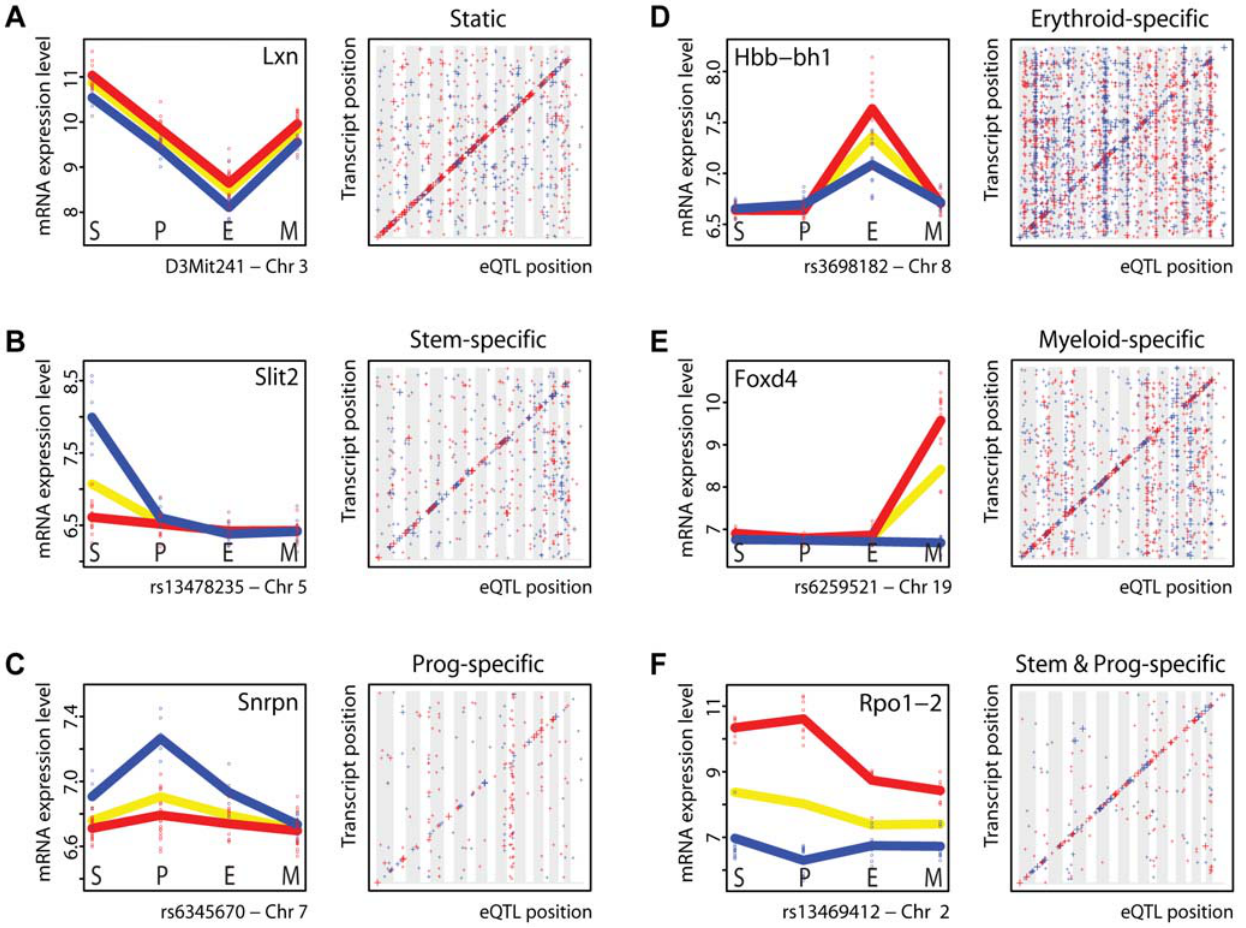
Figure 2. Identification of static and dynamic eQTLs. (A) Genome-wide identification of cell-type–independent static eQTLs. (Left panel) Lxn mRNA levels were analyzed in all 4 cell types. Each circle represents an individual sample (strain). The yellow line shows mean expression levels across all strains. The red and blue lines indicate mean Lxn expression levels in strains that carry the B6 or D2 Lxn allele, respectively. The genetic effect of parental alleles on Lxn expression levels was consistent in all cell types. (Right panel) Individual probes that detected a transcript that was consistently controlled by the same eQTL in all 4 cell types. The y-axis indicates the physical position of the encoding gene; the x-axis provides the genomic position of the marker with strongest linkage statistics. Vertical gray and white bandings indicate different chromosomes, ranging from chromosome 1 to X. The size of each symbol reflects the strength of the genetic association: eQTLs with p -values , 10 2 8 are represented by the largest crosses; p - values between 10 2 6 and 10 2 8 are shown with medium crosses, while small crosses refer to eQTLs with p -values between 10 2 4 and 10 2 6 . The color coding (red and blue) indicates the parental allele of the eQTL that caused a higher gene expression (B6 is red and D2 is blue). (B–E) Genome-wide identification of transcripts that are controlled by cell-type–specific eQTLs. (Left panels) Expression data for some transcripts that were affected by cell-type–specific eQTLs [(B) Slit2 in stem cells, (C) Snrpn in progenitor cells, (D) Hbb-bh1 in erythroid cells, and (E) Foxd4 in myeloid cells]. (Right panels) Genome-wide distribution of eQTLs that were preferentially/uniquely detected in each of the four cell populations. (F) Transcripts that were controlled by eQTLs in both stem and progenitor cells. An example is Rpo1-2 . Full lists of all genes belonging to the eQTL (sub)categories shown here are provided in Table